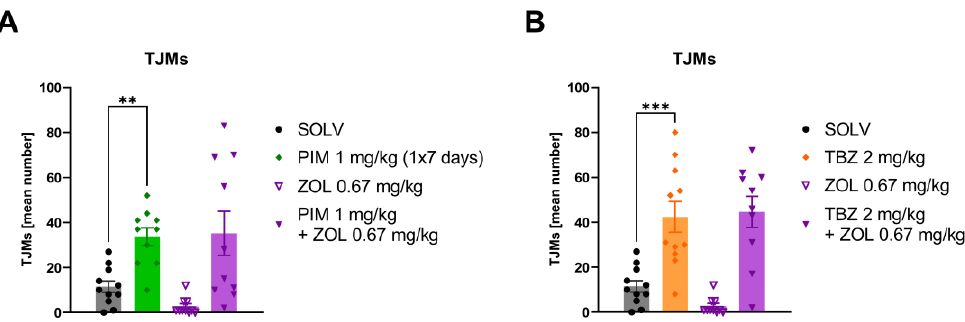
Figure 5. Zolpidem (0.67 mg/kg) had no effect on pimozide-induced ( A ) or TBZ-induced ( B ) trem- ulous jaw movements (TJMs). The data are shown as the mean (±SEM) number of tremulous jaw movements (TJMs) per 10 min observation period. The number of animals: SOLV, n = 11; PIM 1 mg/kg, n = 10; TBZ 2 mg/kg, n = 11; ZOL 0.67 mg/kg, n = 10; PIM 1 mg/kg +ZOL 0.67 mg/kg, n = 10; TBZ 2 mg/kg + ZOL 0.67 mg/kg, n = 10. Statistics: Factorial ANOVA for PIM (PIM effect: F[1,37] = 26.019, p = 0.001; ZOL effect: F[1,37] = 0.446, p = 0.508) and TBZ (TBZ effect: F[1,38] = 51.114, p = 0.001; ZOL effect: F[1,38] = 0.410, p = 0.526) + LSD post-hoc test (** p ≤ 0.01, *** p ≤ 0.001).